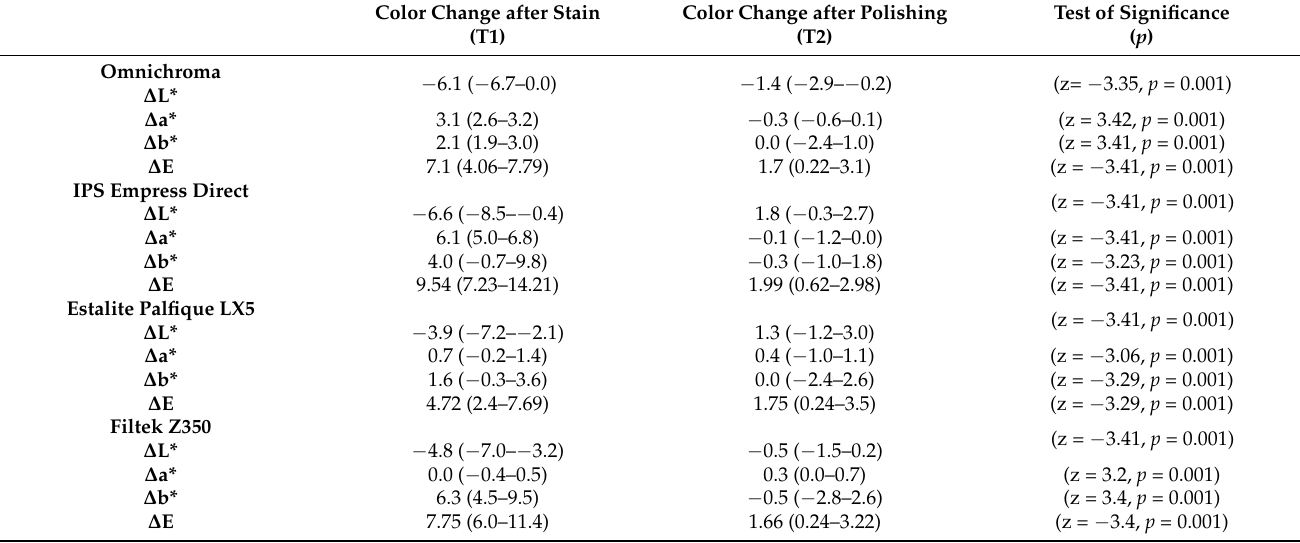
Table 3. Assessment of color change (after stain vs. after polishing) in each group separately.